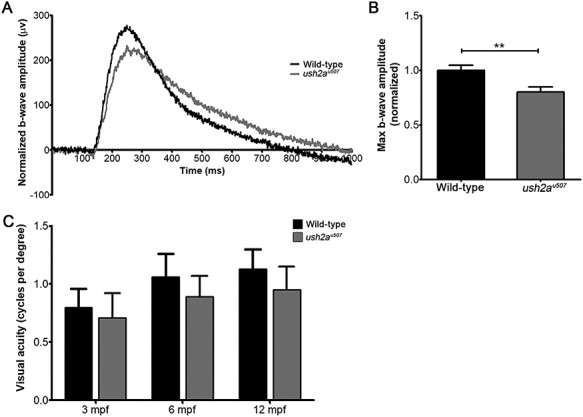
Visual function in ush2au507 zebrafish. (A) Normalized average b-wave amplitude of ERG responses recorded from wt and ush2au507 zebrafish at 5 days post fertilization (wt: n = 69, ush2au507: n = 67). (B) Maximum b-wave amplitudes are plotted as bar graphs (mean ± SEM). (C) Visual acuity (cycles per degree, cpd) of wt and ush2au507 zebrafish at 3 months post fertilization (mpf), 6 mpf and 12 mpf, assessed using the optokinetic response assay (n = 4–5, mean ± SEM). **P < 0.001. Mann Whitney tests and two-way ANOVA were used to test for statistical significance in ERG and optokinetic response data, respectively.